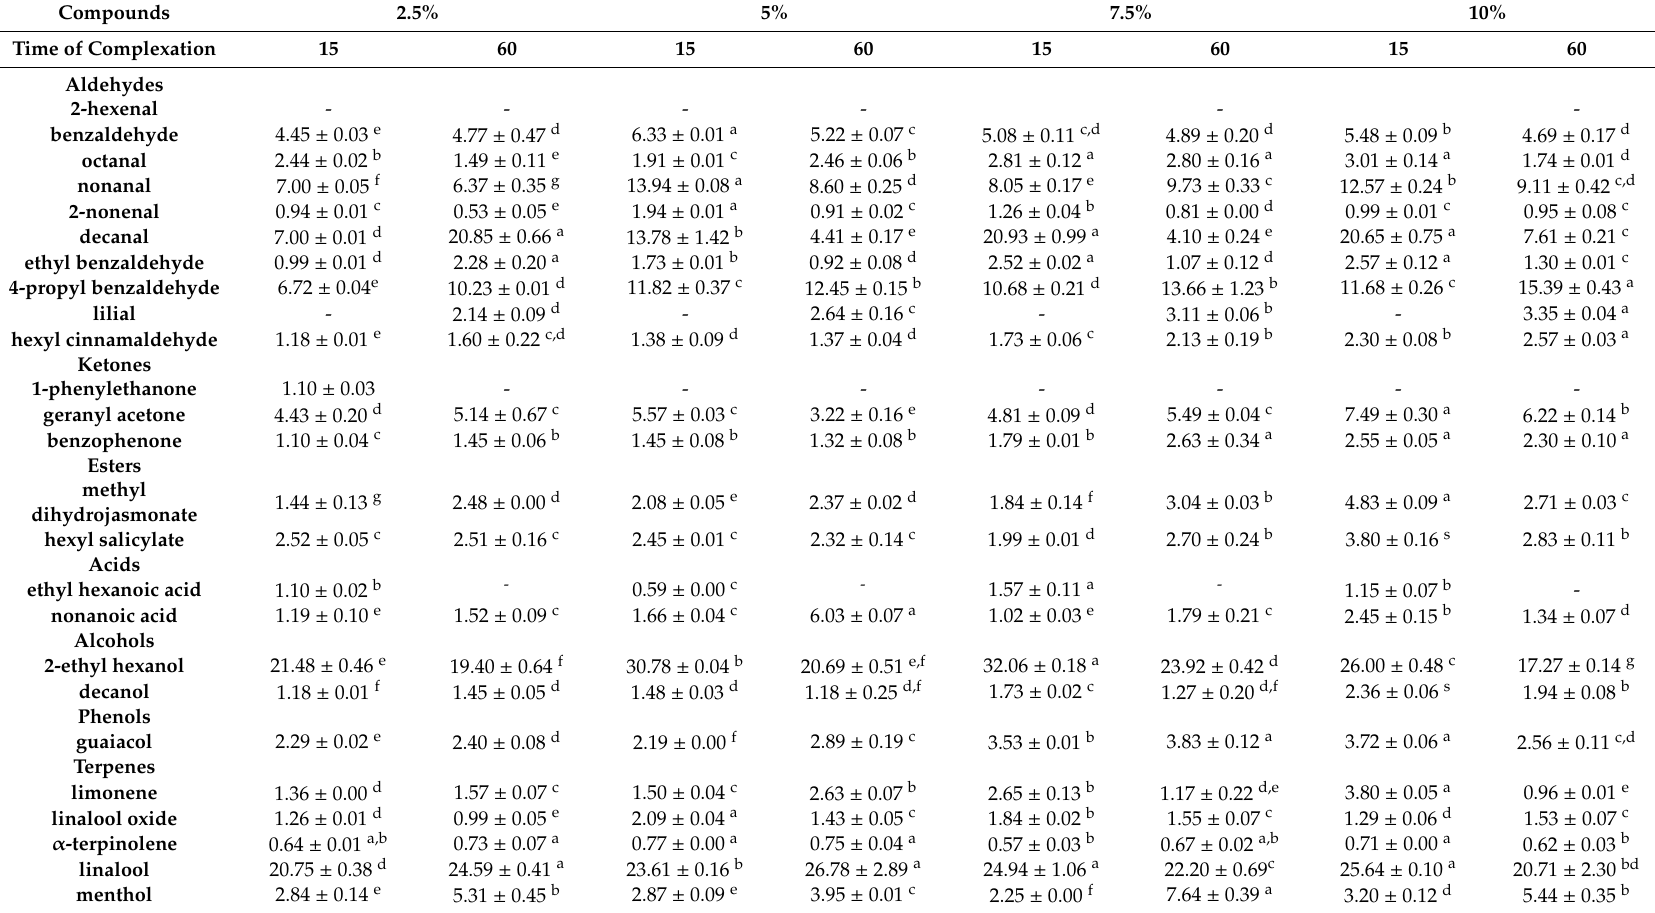
Table 3. Volatile compounds ( µ g / kg) of cellulose / raspberry complexes prepared by 15 min and 60 min of complexation (2.5%, 5%, 7.5% and 10%—amounts of used cellulose) after